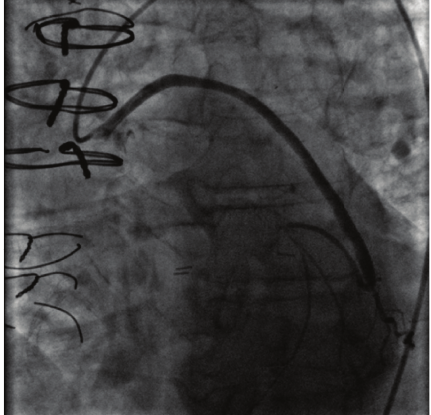
Figure 4: Conventional angiography shows a widely patent saphe- nous vein to obtuse marginal graft.